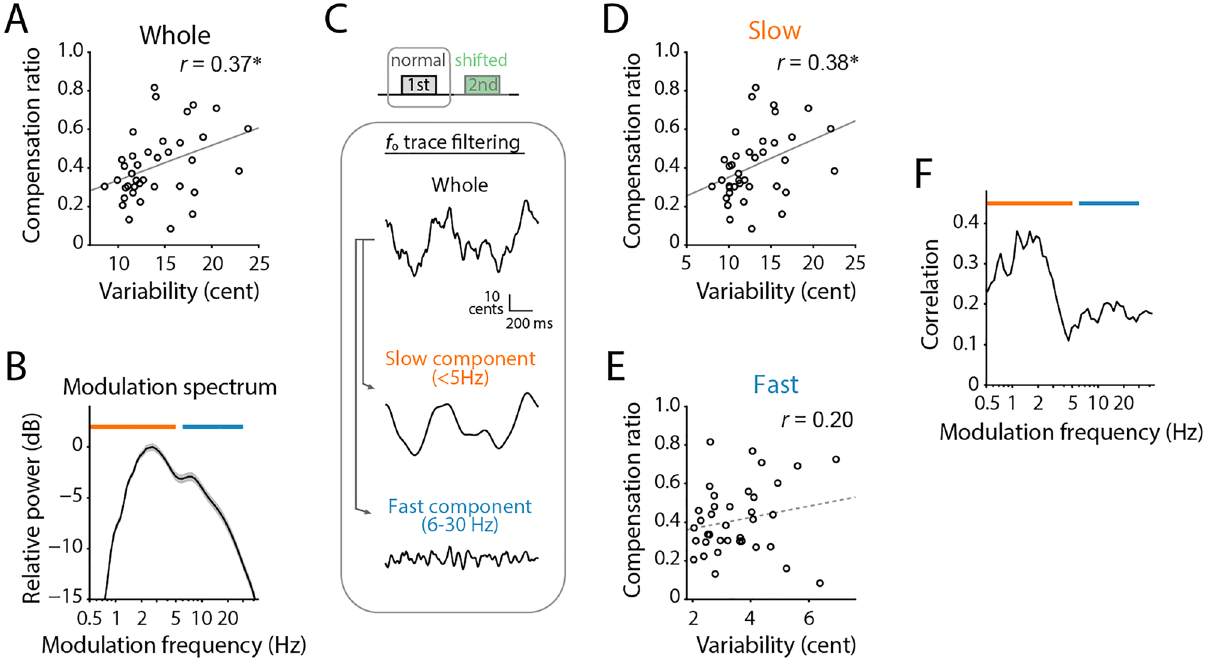
Figure 2. Spontaneous f o variability during vocalizations without modification in auditory feedback, and its relationship with the compensation ratio. ( A ) The relationship between the compensation ratio and variability calculated from original (whole) f o trajectories during no f o shifts. Each circle indicates the data from one participant. r indicates Pearson’s correlation coefficient. Two participants who showed negative values in the compensation ratio were excluded as outliers. Asterisk (*) indicates statistically significant correlation ( p < 0.05). ( B ) Modulation spectrum of spontaneous fluctuation in vocal f o trajectories computed by a 1/2-octave filter bank (see “Methods” for detail). Gray area indicates the standard error among 40 participants. Orange and blue lines indicated frequency ranges of slow and fast fluctuation components, respectively. ( C ) Examples of filtering on the original (whole) f o trajectory to obtain the slow and fast fluctuation components (slow: ≤ 5 Hz, fast: 6–30 Hz). ( D , E ) Correlation between the compensation ratio and variability of slow ( D ) or fast ( E ) fluctuation components, respectively. ( F ) Correlation coefficient between the compensation ratio and the variability of each modulation sub-band as a function of the center frequency of half-octave filter